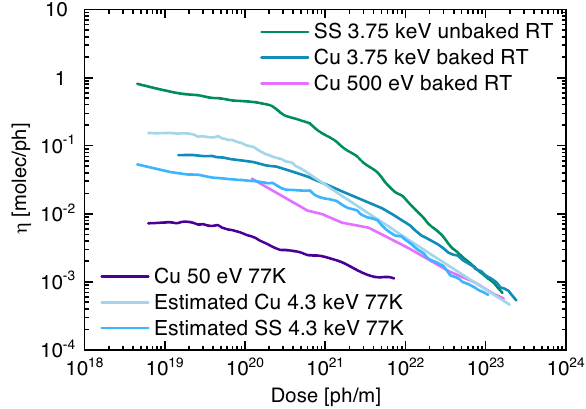
FIG. 5. Spectrum of the SR arriving to the CB and to the inner ) for ph;H 2 eq chamber [7], with most part of their photon flux below Cu ’ s work function. Calculated with SYNRAD +. Figure taken from